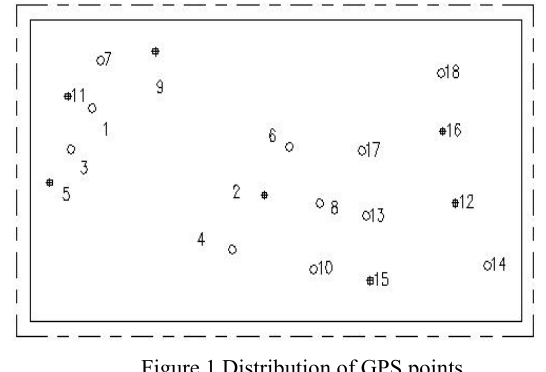
Figure 1 Distribution of GPS points